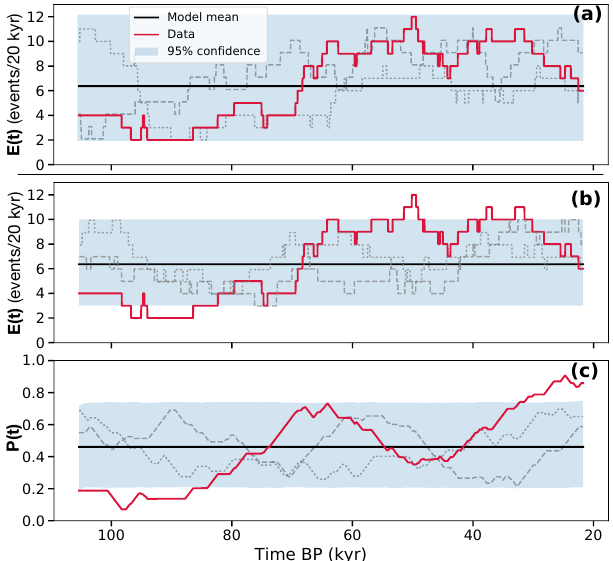
Figure 4. Point-wise 95% confidence bands and model mean (black line) for the time-varying indicators E ( t ) and P ( t ) from Monte Carlo simulations. (a) E ( t ) for the stationary one-process model. (b) E ( t ) and (c) P ( t ) for the stationary two-process model. The indicators for the data are shown in red and two typical model realizations are shown in gray. and range 1. Figure 5 shows the time-dependent transition rates as obtained from the parameter fit. For the one-process model we obtain